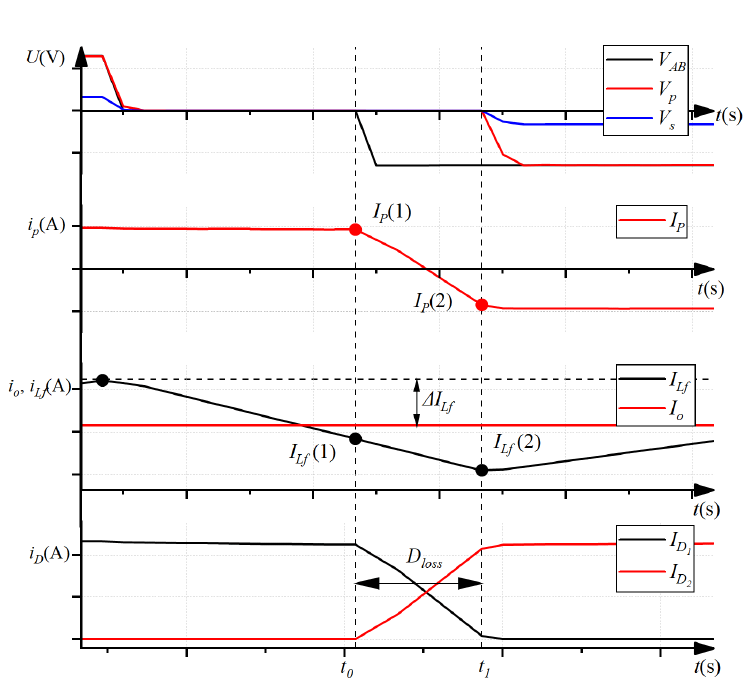
Figure 3. Loss of duty cycle during voltage clamping of transformer